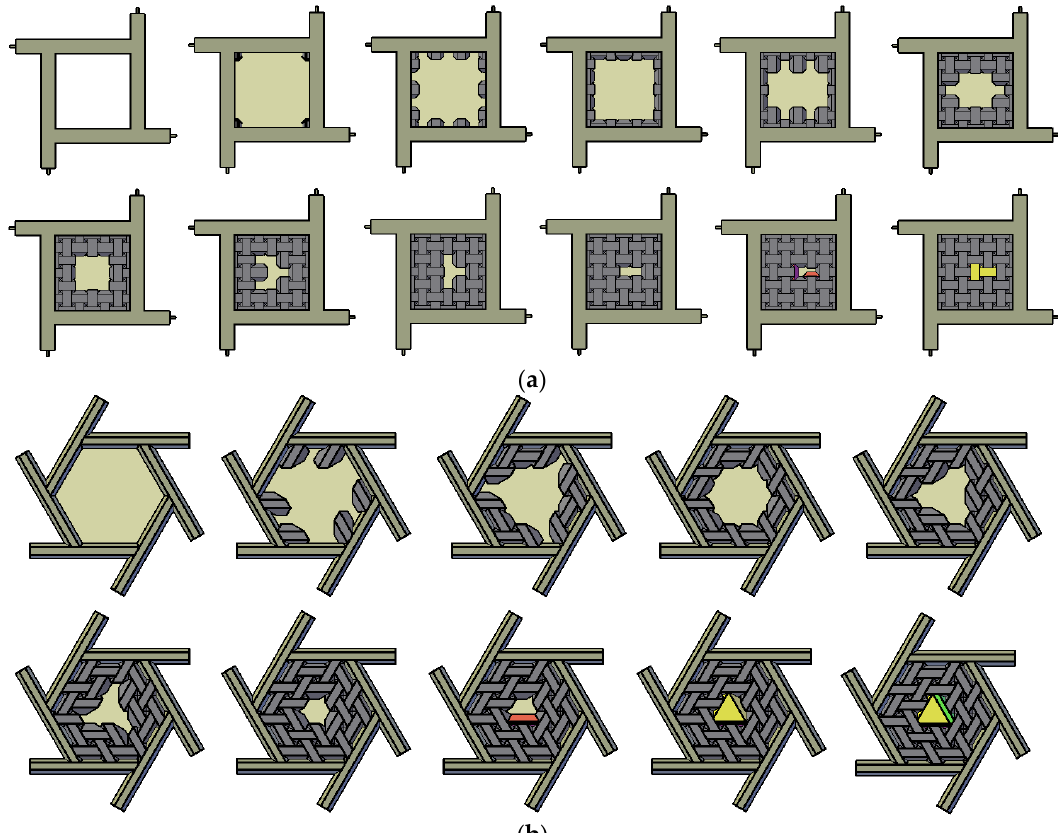
Figure 23. Order of laying prefabs: ( a ) in a square field; and ( b ) in a hexagonal field.